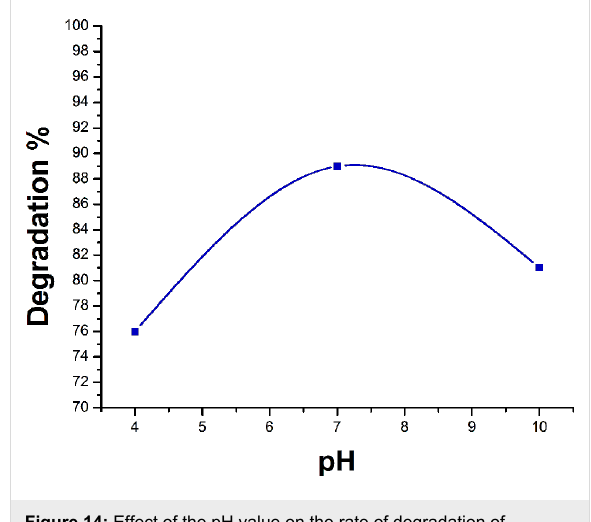
Figure 14: Effect of the pH value on the rate of degradation of rhodamine B.